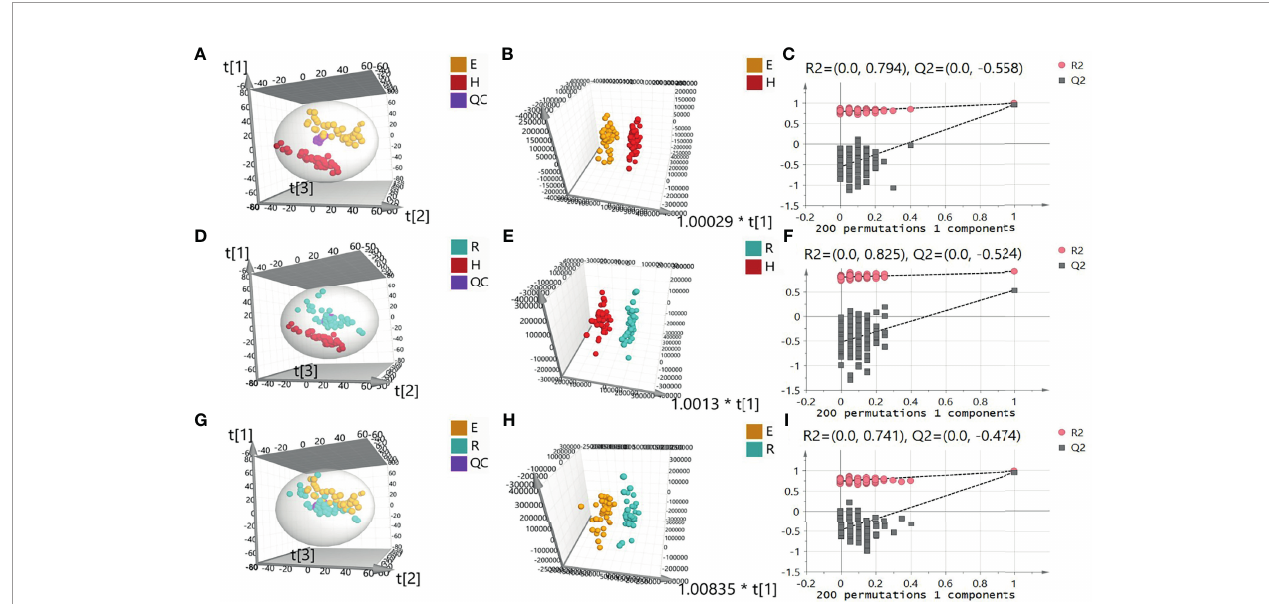
FIGURE 2 | Principal component analysis (PCA) diagram of serum samples of EOLP group and HC group (A) , ROLP group and HC group (D) , EOLP group and ROLP group (G) in the negative ion mode, OPLS-DA score diagram (B, E, H) and 200 permutation test (C, F, I) of EOLP group and HC group, ROLP group and HC group, EOLP group and ROLP group in the negative ion mode. E: EOLP; R: ROLP; H: